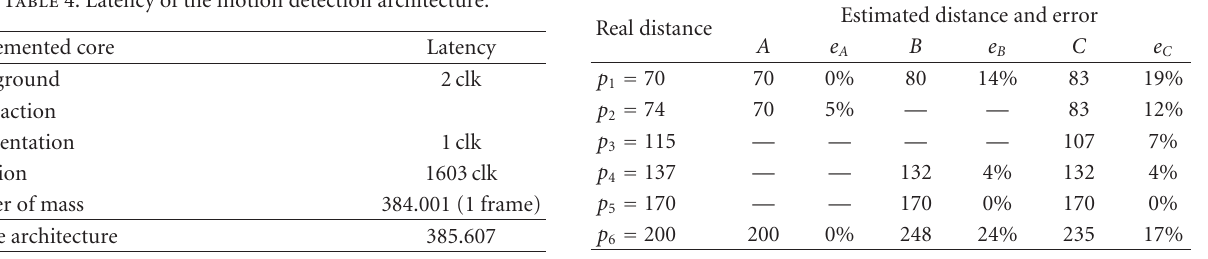
Table 4: Latency of the motion detection architecture.